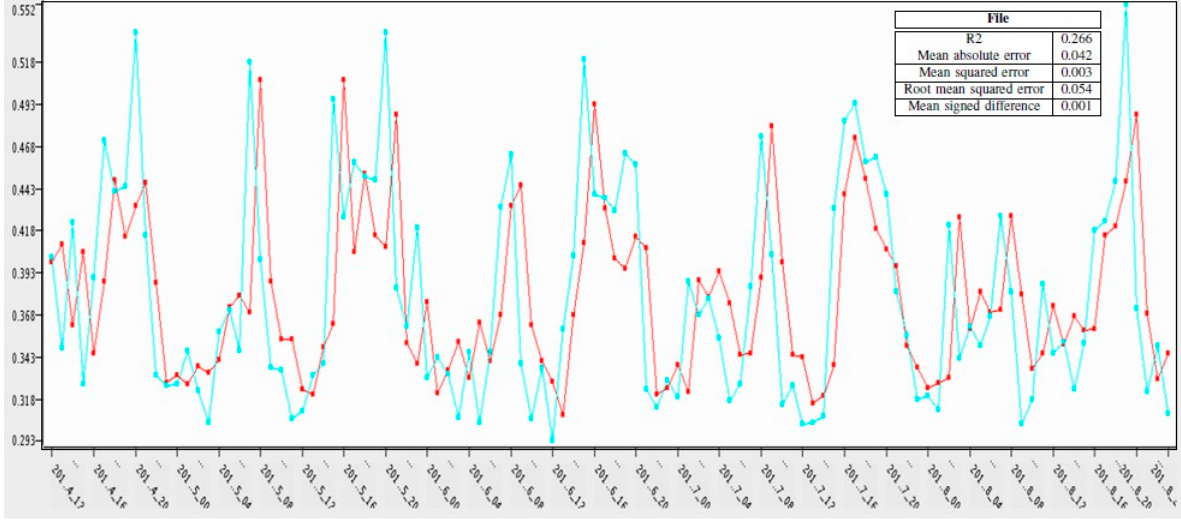
Figure 12. Output of statistics node for ANN and neural network (i.e., blue colour represents the actual value while the red colour represents the predicted